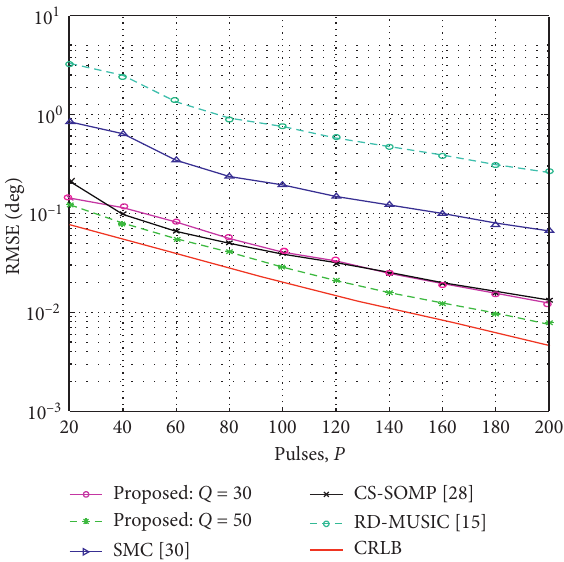
Figure 4: RMSE versus number of P .